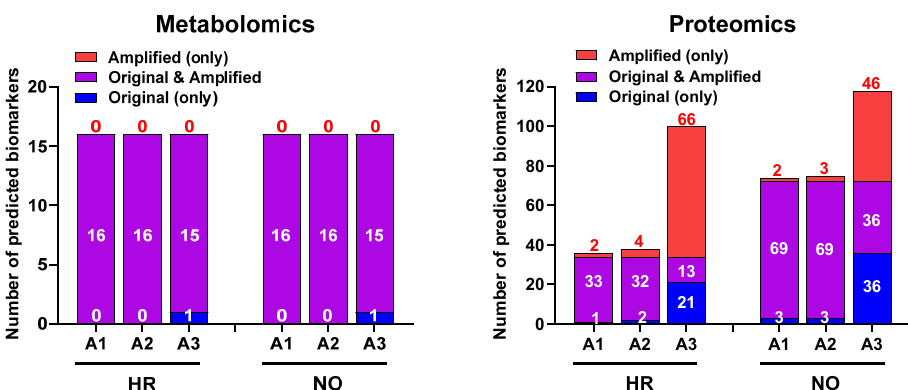
AmplifiedAmplified (only) (only)Original & Original